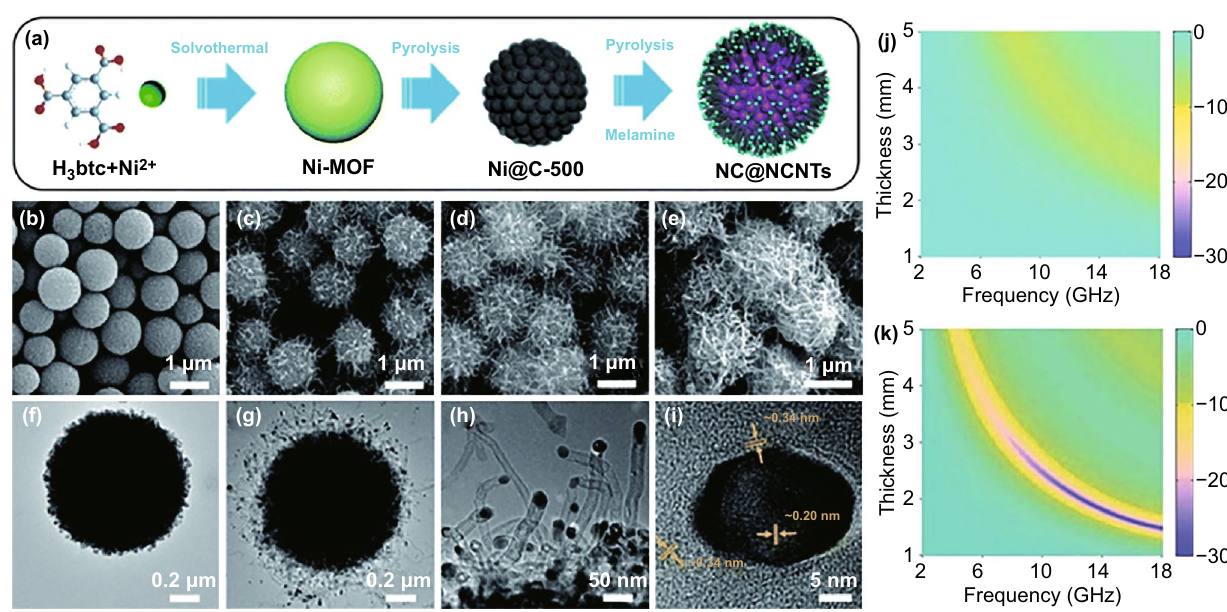
Fig. 4 a Schematic of the preparation of the NC@NCNTs. SEM images of b NC, c NC@NCNTs-1, d NC@NCNTs-2, and e NC@NCNTs-3. TEM images of f NC and g‑i NC@NCNTs-2. RL maps of j NC, k NC@NCNTs-2. Reproduced with permission from Ref. [96]. Copyright © 2021 The Royal Society of